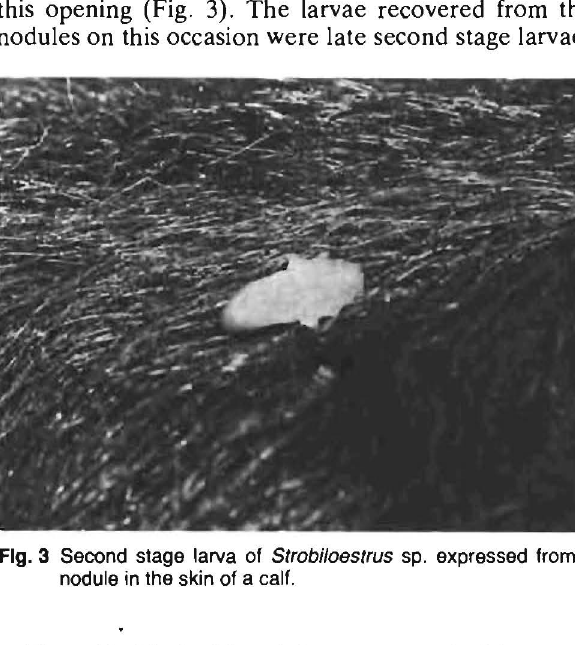
The calf with the 31 nodules was treated with a pour on formulation of famphur (Warbex: Coopers SA (Pty) Ltd.) administered on its hide along the length of its